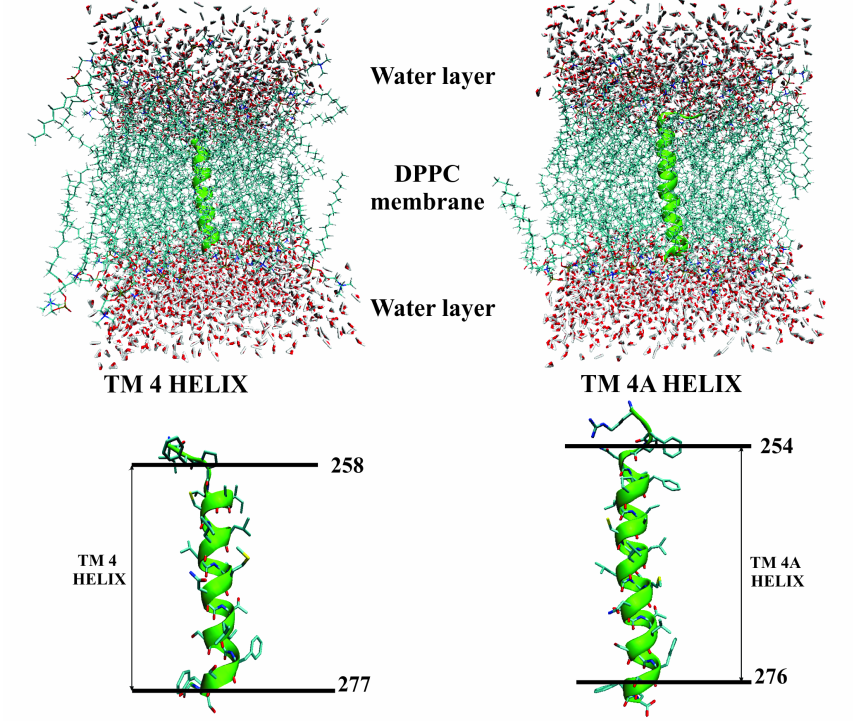
Figure 1. Simulation models of TM4 ( left ) and TM4A ( right ) transmembrane bilitranslocase (BTL) segments inserted into the dipalmitoylphosphatidylcholine (DPPC) membrane in the aqueous medium. Representative snapshots of the TM4 and TM4A α -helices with approximate borders of the helical structures